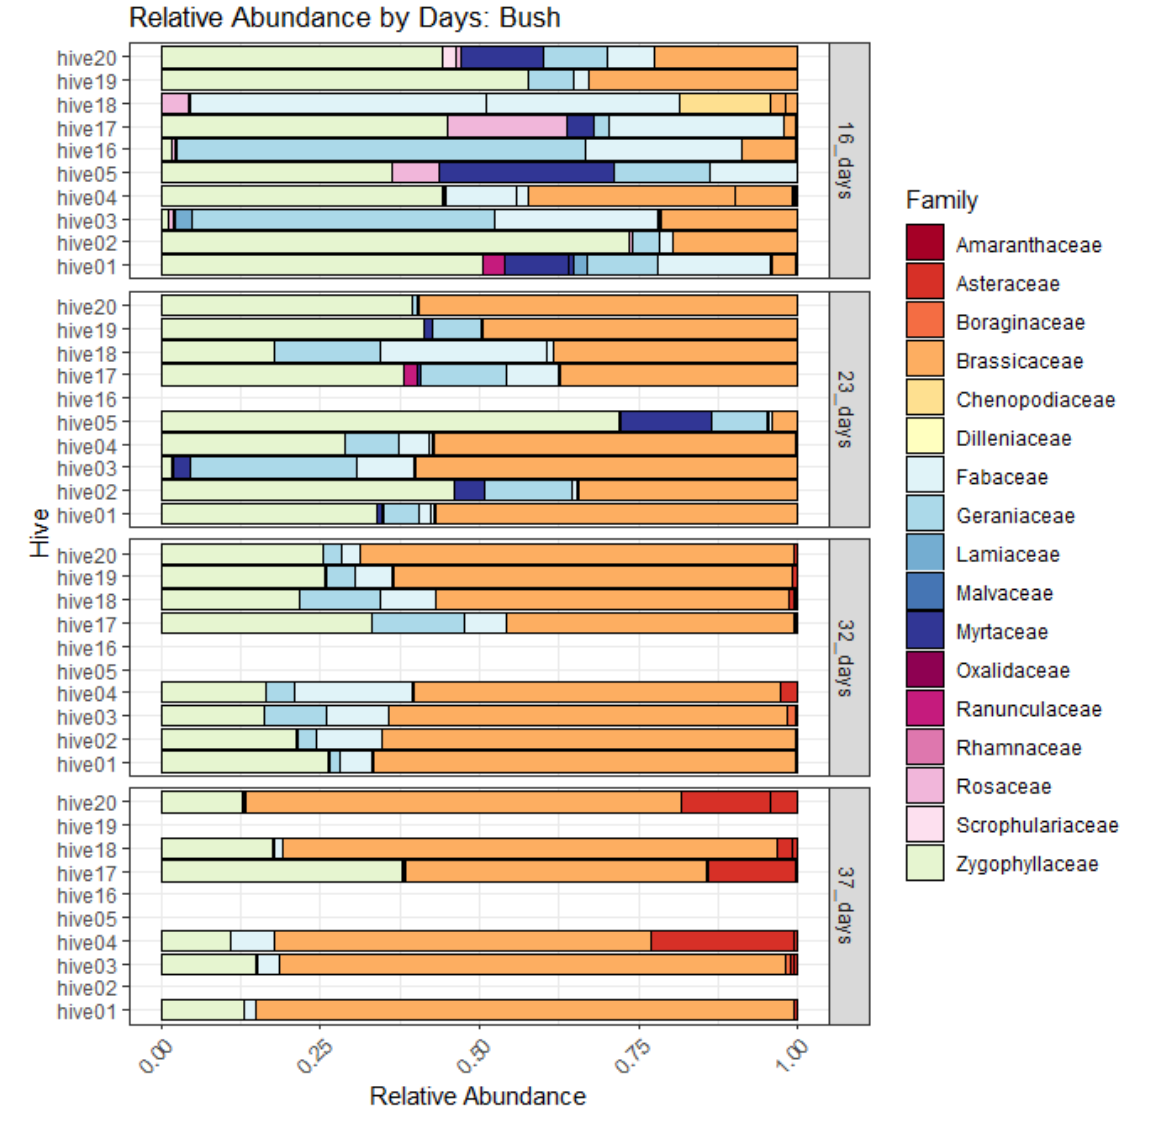
Figure 11. Composition of amplicon sequence variants (ASVs) concatenated by plant families from metabarcoding of the ITS2 marker based on honey-bee-collected pollen, sampled from hives at 16, 23, 32, and 37 days after placement in Mallee bushland.